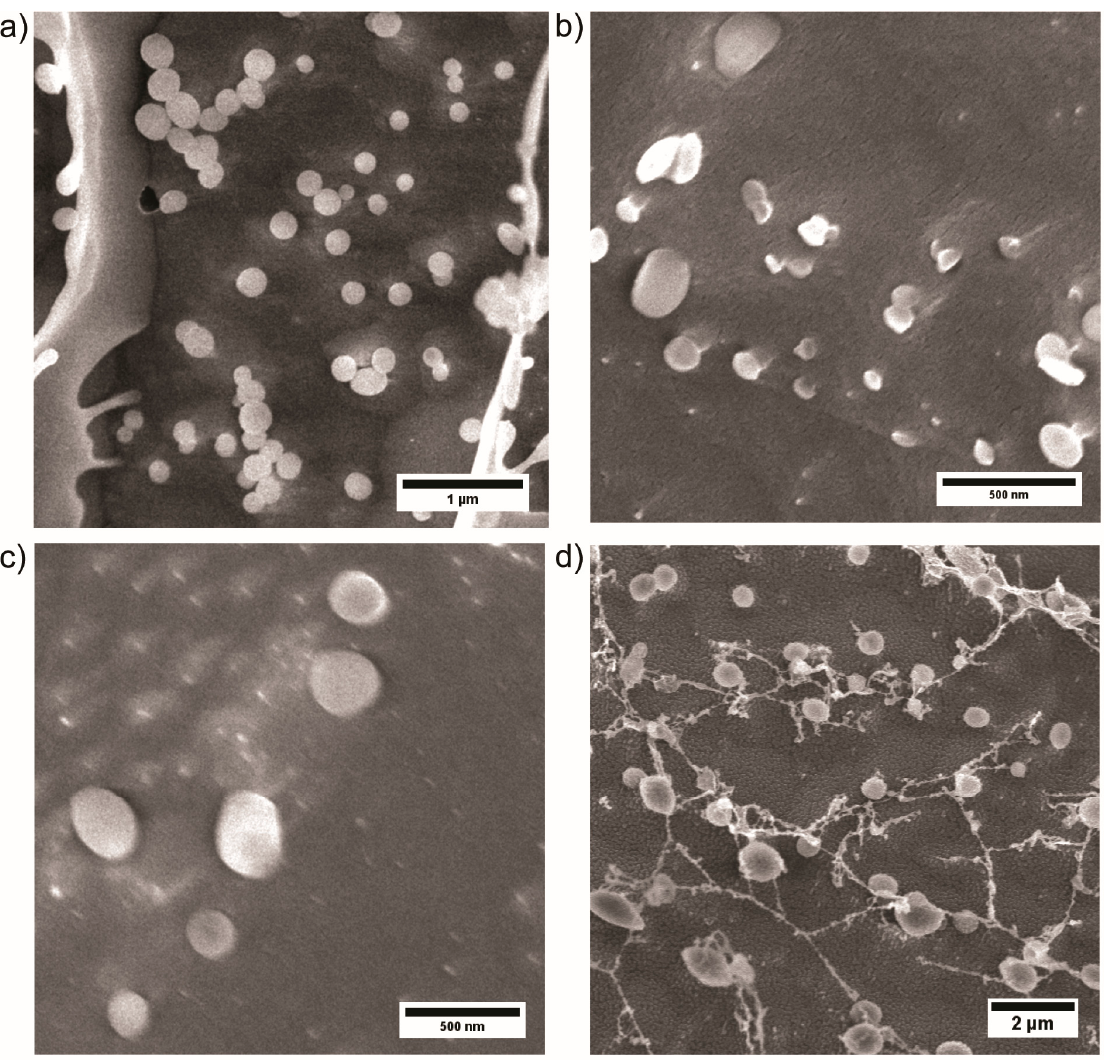
Figure 4. Cryo SEM images of block copolymers at a concentration of 0.5 wt % in water: ( a ) PEtOx 22k - Cryo SEM images of block copolymers at a concentration of 0.5 wt % in water: b -PVP 10k ; ( b , c ) PEtOx 22k - b -PVP 14k and ( d ) PEtOx 22k - b -PVP 32k . ( a ) PEtOx 22k - b -PVP 10k ; ( b , c ) PEtOx 22k - b -PVP 14k and ( d ) PEtOx 22k - b -PVP 32k